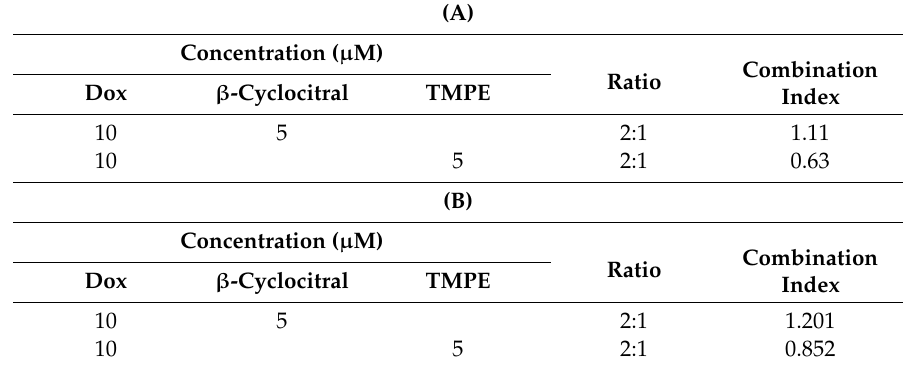
Table 1. Combination β -cyclocitral and its derivative TMPE with doxorubicin (Dox) against LoVo / Dx ( A ) and HT29 / Dx ( B ) cell growth.